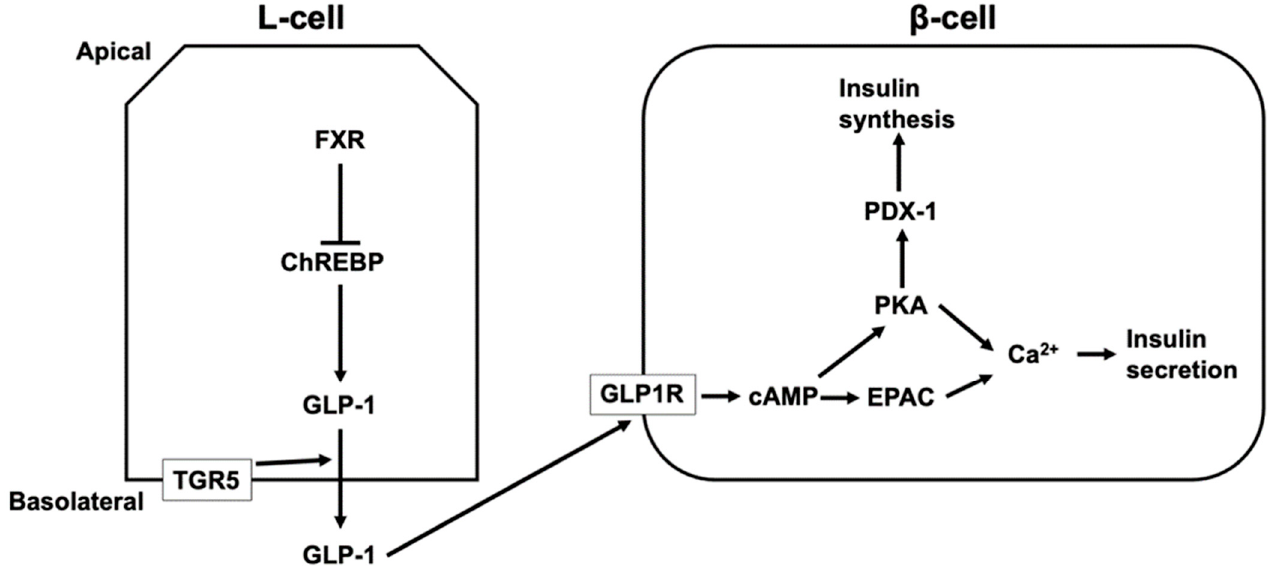
Figure 3. The regulation of insulin secretion and synthesis via TGR5 and FXR. TGR5 located in the basolateral membrane of L-cells mediates glucagon-like peptide 1 (GLP-1) secretion from L-cells, and secreted GLP-1 from the intestine reaches pancreatic β -cells via the systemic circulation. The binding of GLP-1 to GLP-1 receptor (GLP1R) increases cyclic AMP (cAMP) levels, leading to the activation of protein kinase A (PKA) and exchange proteins directly activated by cAMP (EPAC), which induces an increase in intracellular Ca 2+ and insulin secretion. In addition, the activation of PKA by GLP-1 leads to the activation of pancreatic duodenal homeobox-1 protein (PDX-1), which binds to the promoter of the gene encoding insulin and induces the synthesis of insulin. FXR suppresses GLP-1 production in L-cells by inhibiting the activity of a carbohydrate responsive element binding protein (ChREBP) that induces the expression and secretion of GLP-1 in L-cells.